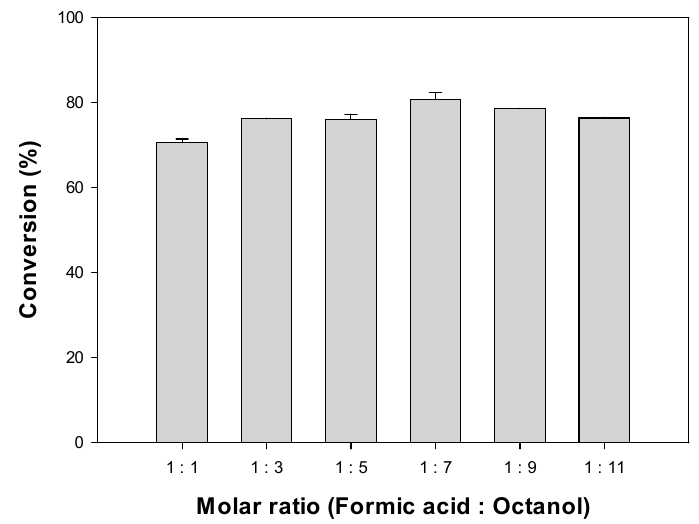
Figure 4. Effect of molar ratio of octyl formic acid and octanol on the octyl formate conversion.